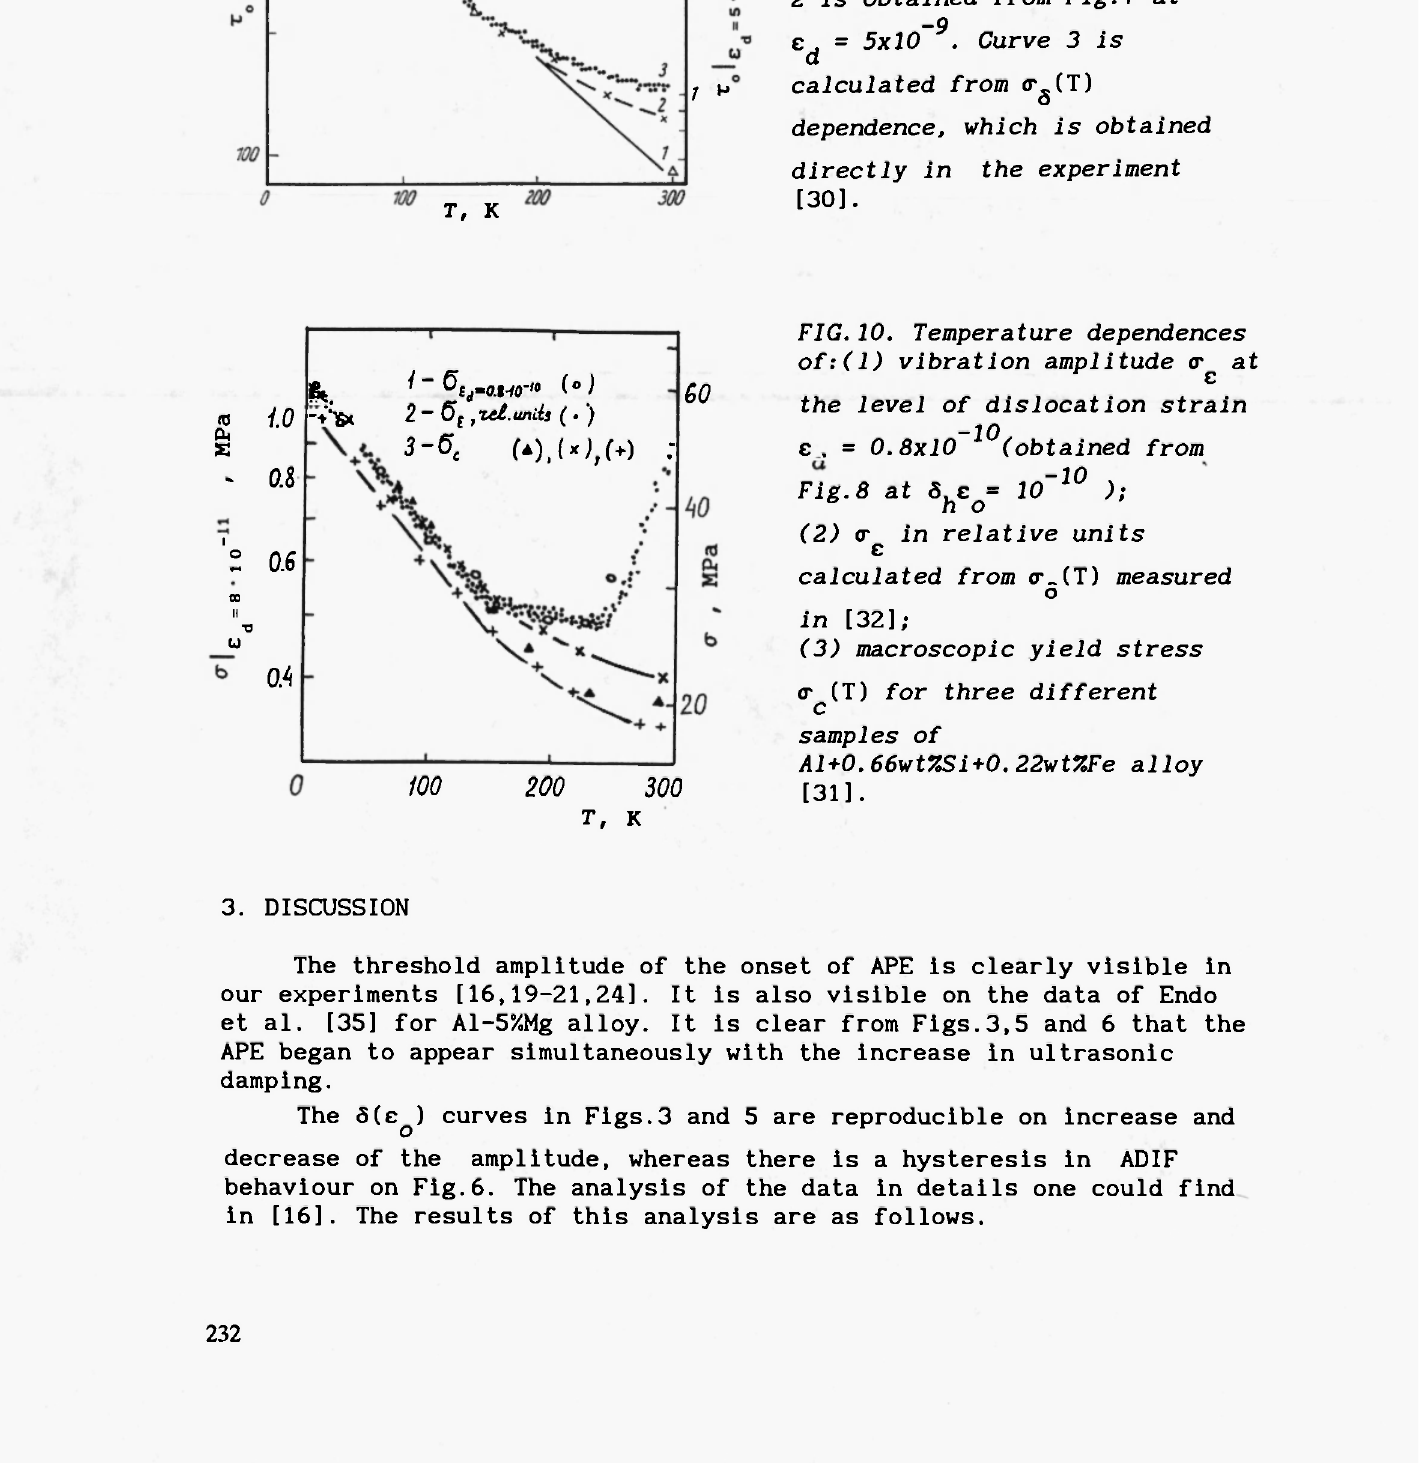
FIG.9. Temperature dependences of the critical resolved shear stress (curve 1) and the vibrational stress amplitude τ providing a constant level of reversible inelastic strain ε =const.(curves 2 and 3). Curve d 2 is obtained from Fig.7 at -9 ε, = 5x10 . Curve 3 is α calculated from «^(T) 1 » dependence, which is obtained directly in the experiment [30]. Τ, κ